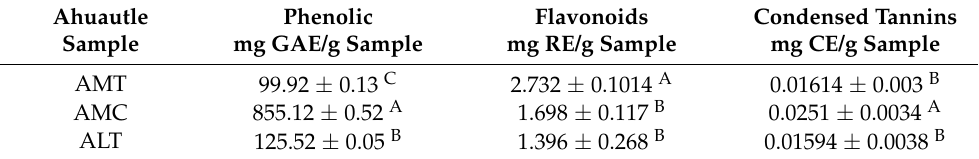
Table 3. Phenolic compounds content in Corixidae eggs using methanol